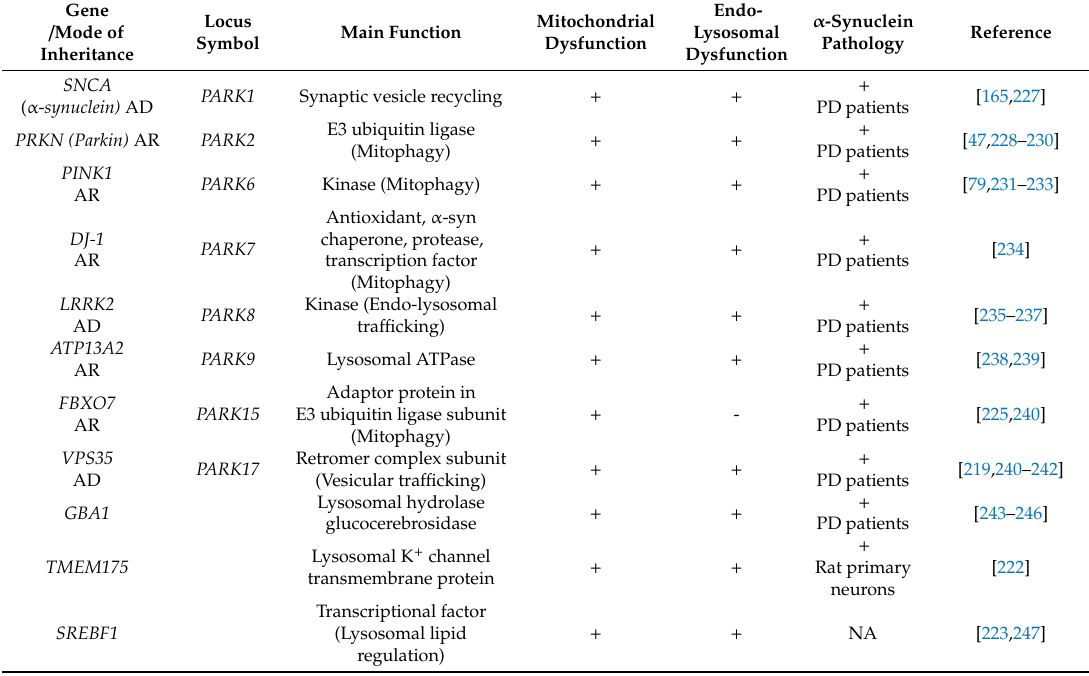
Table 1. Selected PD associated genes and their mitochondria, endo-lysosomal system, and α -synuclein pathology